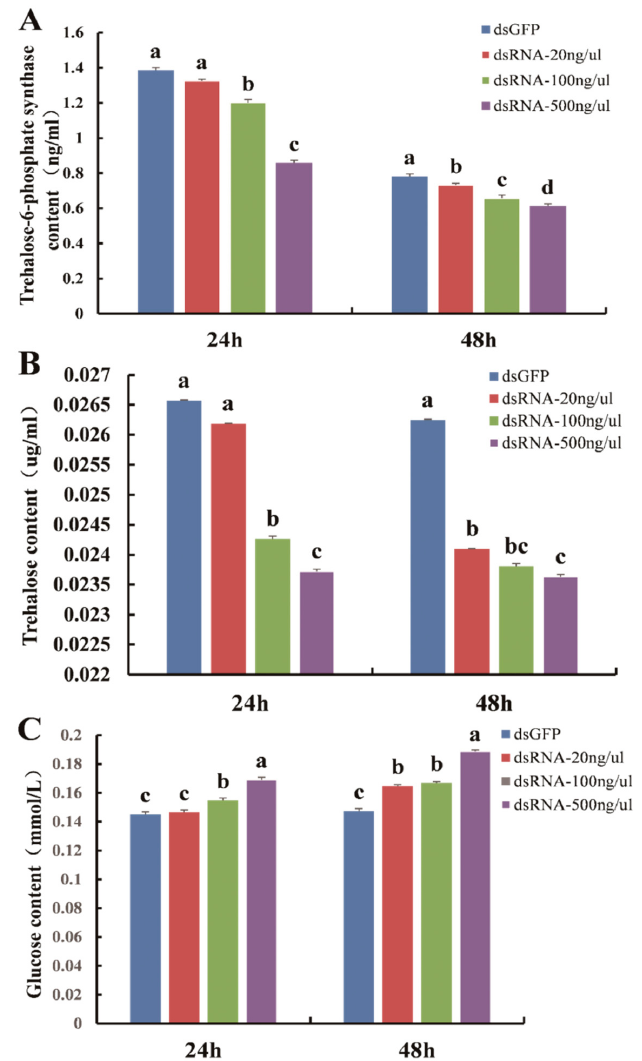
Figure 7. Detection of trehalose-6-phosphate synthase content ( A ), trehalose content ( B ) and glucose content ( C ) in D. citri after feeding dsRNA for 24 and 48 h. Bars with different letters are significantly different according to SNK test ( p < 0.05).